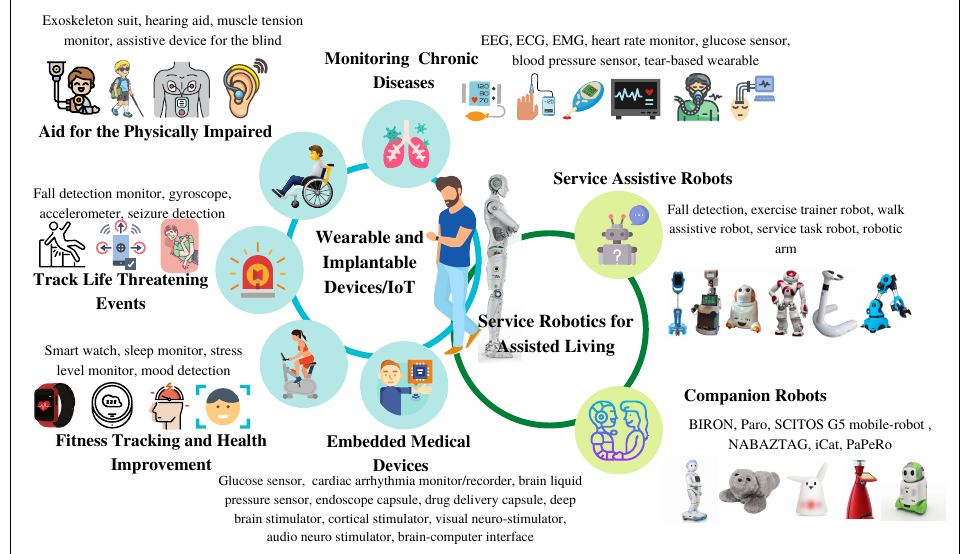
Figure 4. Types ofhealthcare IoT devices and service assistive